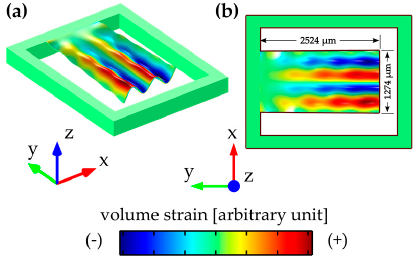
Figure 2 . Visualization in side view in ( a ) and in top view in ( b ) for a plate excited in the fourth-order of the roof tile-shaped mode (15-mode). The colored areas on the cantilever surface represent the local volume strain distribution.